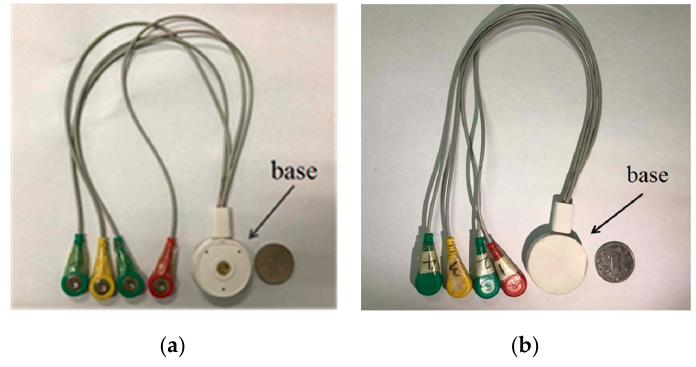
Figure 3. ( a ) Front and ( b ) back sides of the fetal ECG collector circuit board.